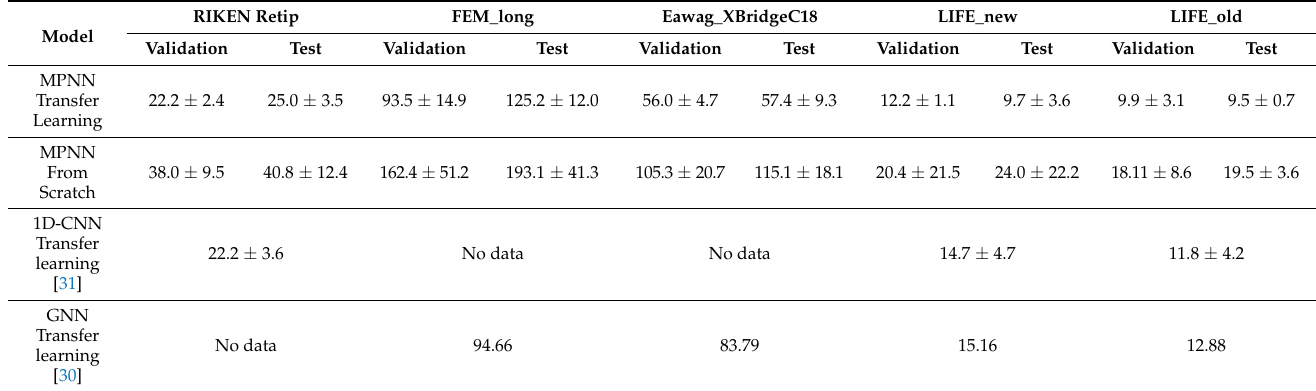
Table 3. Median absolute error (in seconds) for 5-fold cross-validation of MPNN compared with previously published